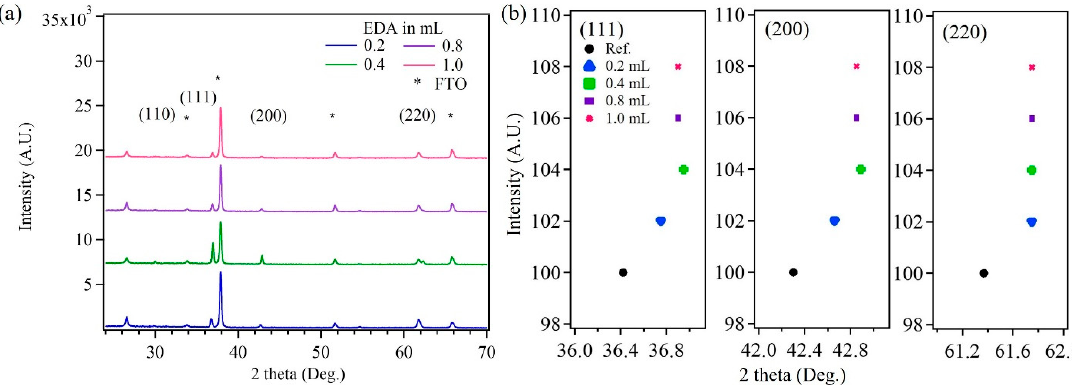
Figure 2. ( a ) XRD plots of Cu 2 O samples with varying ethylenediamine (EDA) contents; ( b ) The right shift in the 2-theta values for (111), (200) and (220) planes.